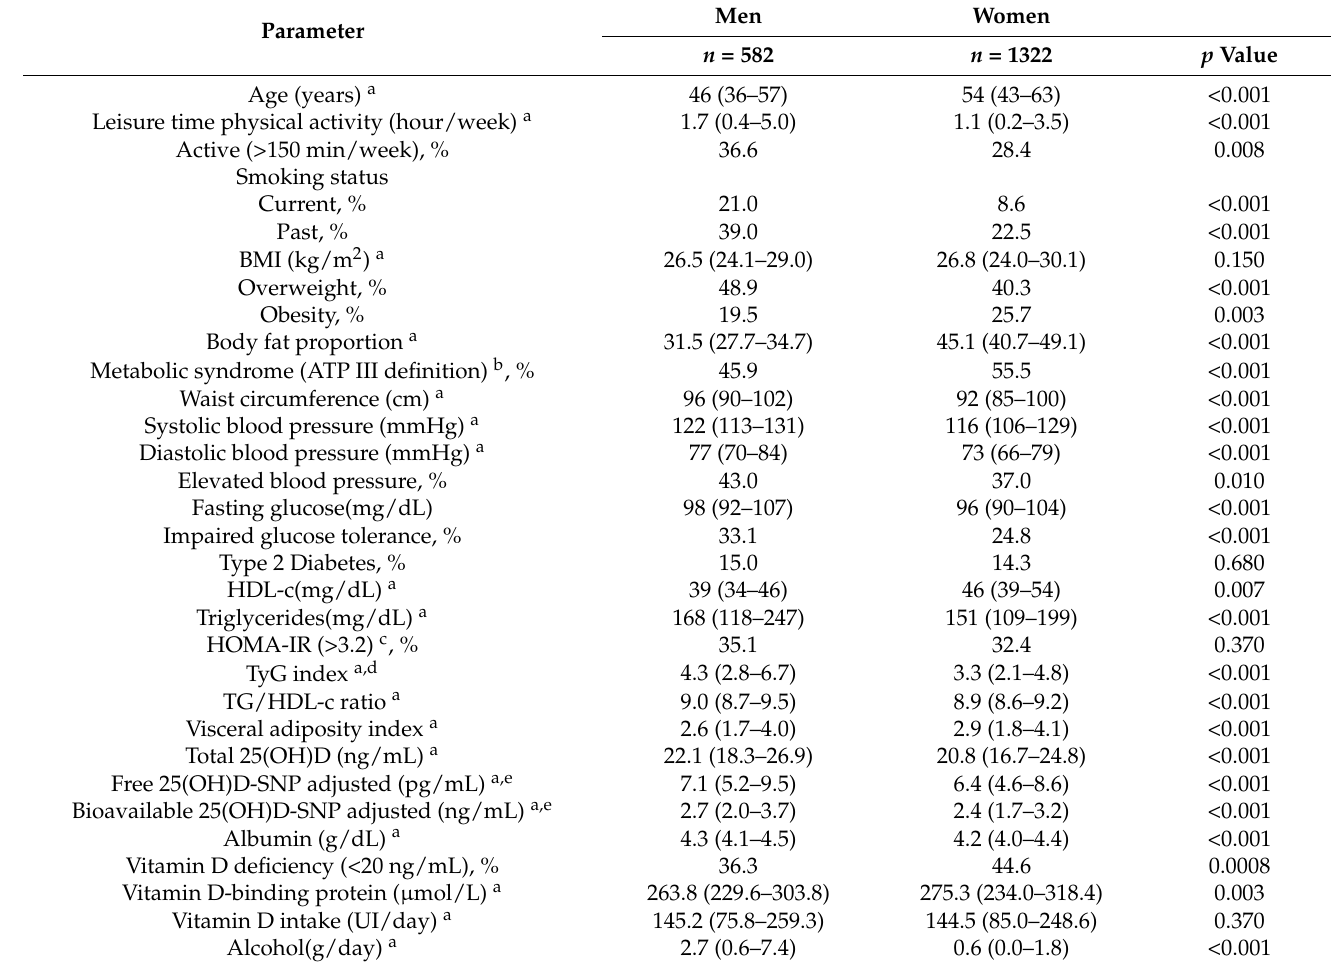
Table 1. Demographics of 1904 individuals who belong to the Health Workers Cohort